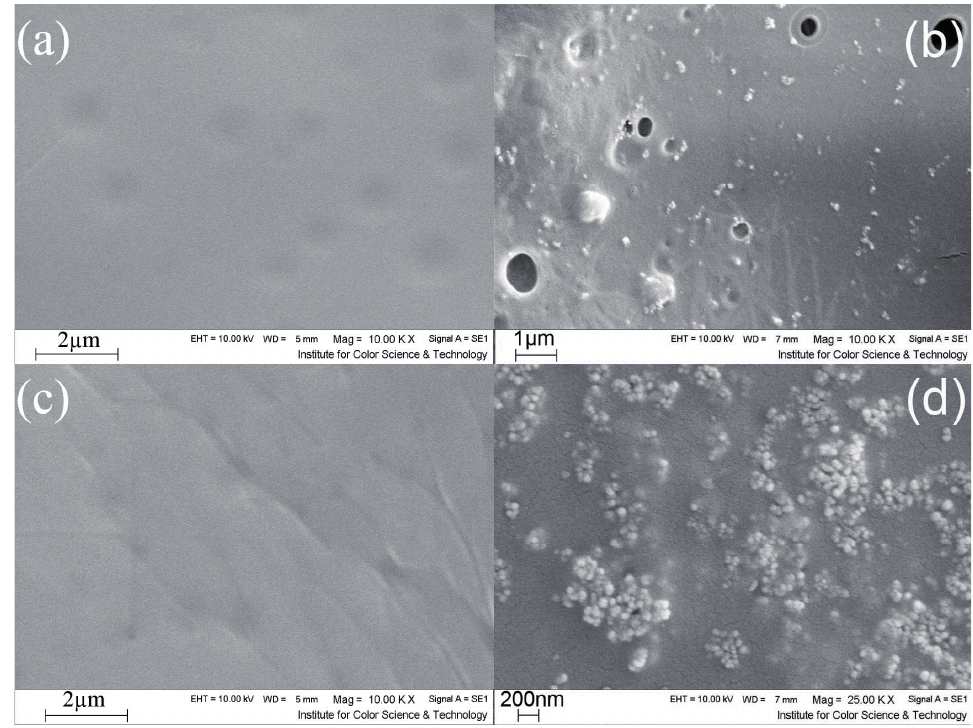
Figure 6. SEM images of (a) pure PMMA (b) PMMA/Sb 2 O 3 -Br (c) pure PS (d) PS/Sb 2 O 3 -Br compound.